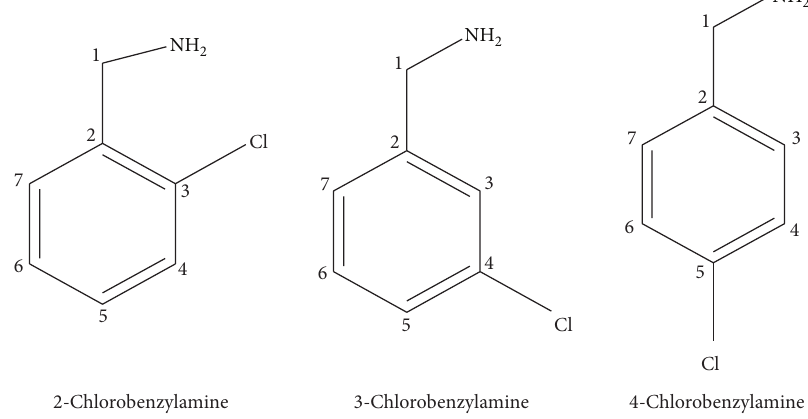
Figure 1: Structures of the ligands (L = BLs).